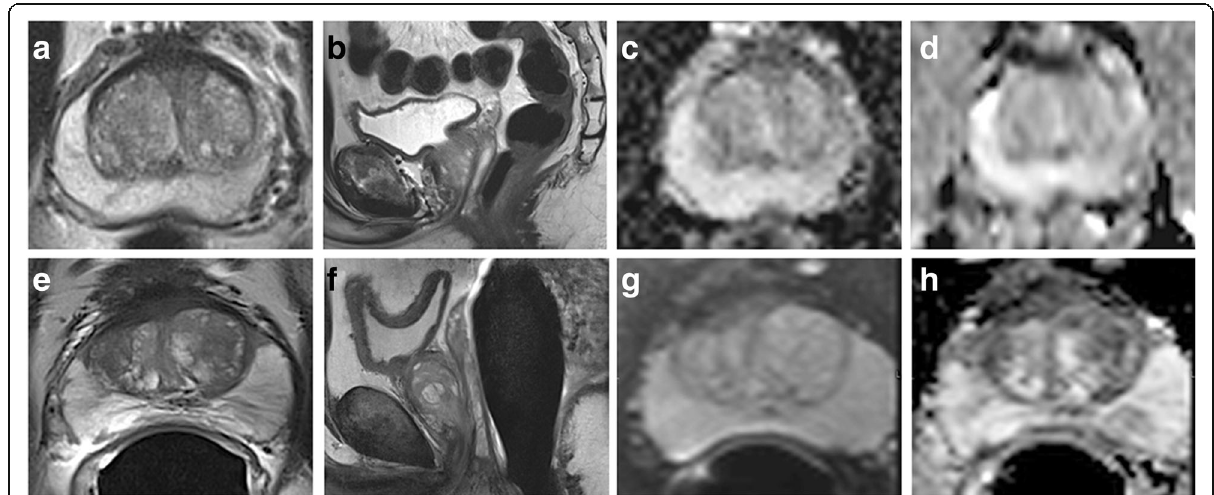
Fig. 5 Biparametric magnetic resonance imaging at 3.0 T in patients with benign prostate hyperplasia was performed without endorectal coil at site 1 ( a – d ) and with endorectal coil at site 2 ( e – h ) included in a multichannel phased-array coil system: axial ( a , e ) and sagittal ( b , f ) T2-weighted imaging, axial diffusion-weighted imaging with a b value of 800 s/mm 2 ( c , g ), and corresponding apparent diffusion coefficient map ( d , h ) obtained with a reduced field of view